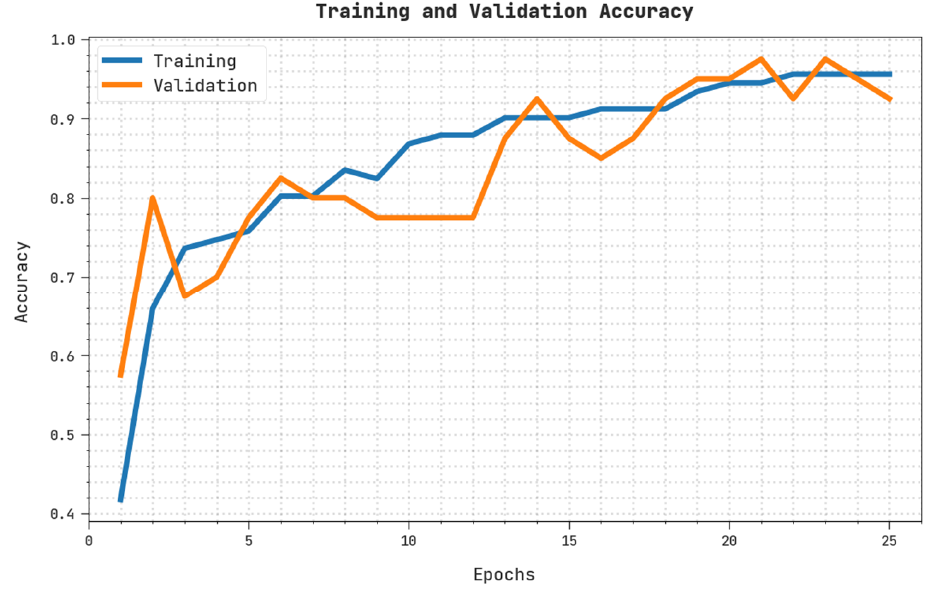
and VLA. The VLA is greater than TRA. Figure 7. Result analysis of OIDCNN-OPMDD approach under 30% of TS data. Figure 7. Result analysis of OIDCNN-OPMDD approach under 30% of TS data.